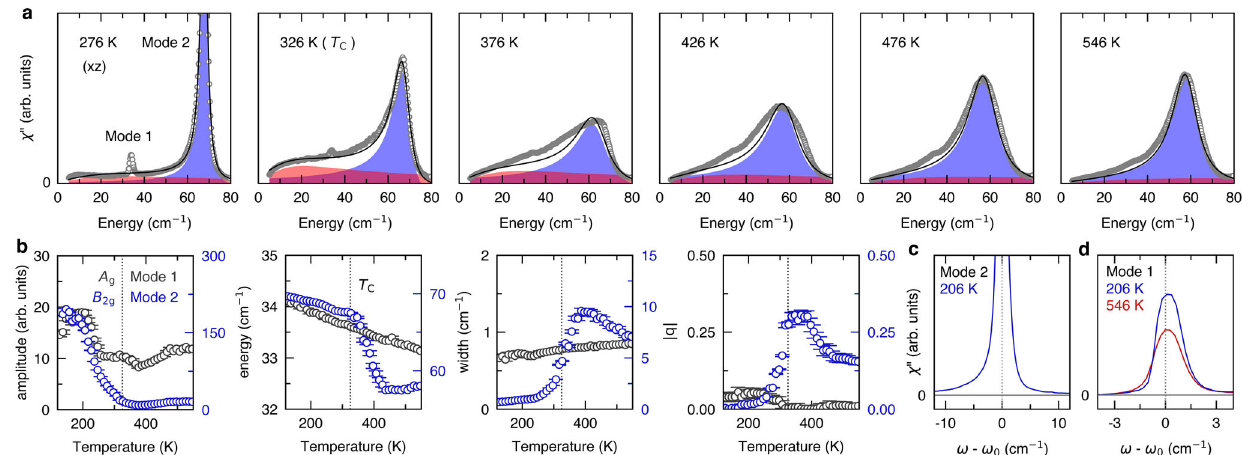
Fig. 3 Excitonic fl uctuations and phonon lineshapes. a Mode 2 (blue) fi tted with the Fano lineshape and QEP (red) with the damped harmonic oscillator lineshape. b Peak amplitude, energy, width, and absolute value of Fano asymmetry q extracted from the fi tting, and the error bars represent the standard deviation in the fi tting procedure. Black dashed line indicates T C . c Mode 2 remains asymmetric well below T C . d Mode 1 also becomes asymmetric in the low-temperature insulating phase. Black dashed lines in ( c ) and ( d ) represent the center energy of Mode 2 and Mode 1,